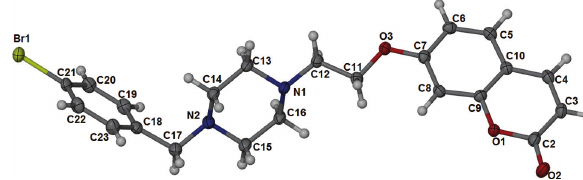
Table 1: Data collection and handling.